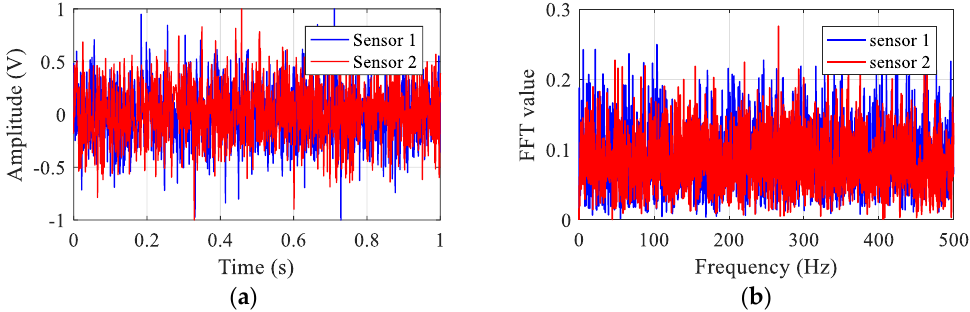
Figure 3. Simulated signals in the pipe without leakage: ( a ) in the time domain; ( b ) in the frequency domain.